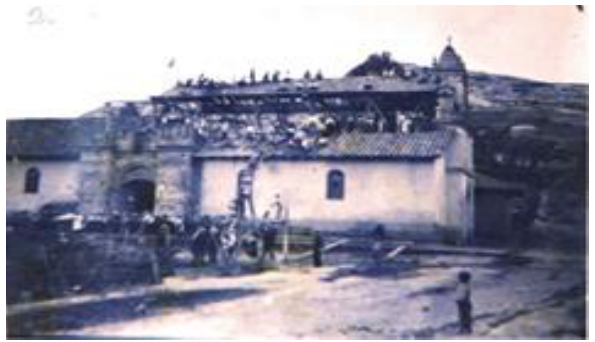
Figure 3 . San Juan Bautista’s church in Nabón (1940)